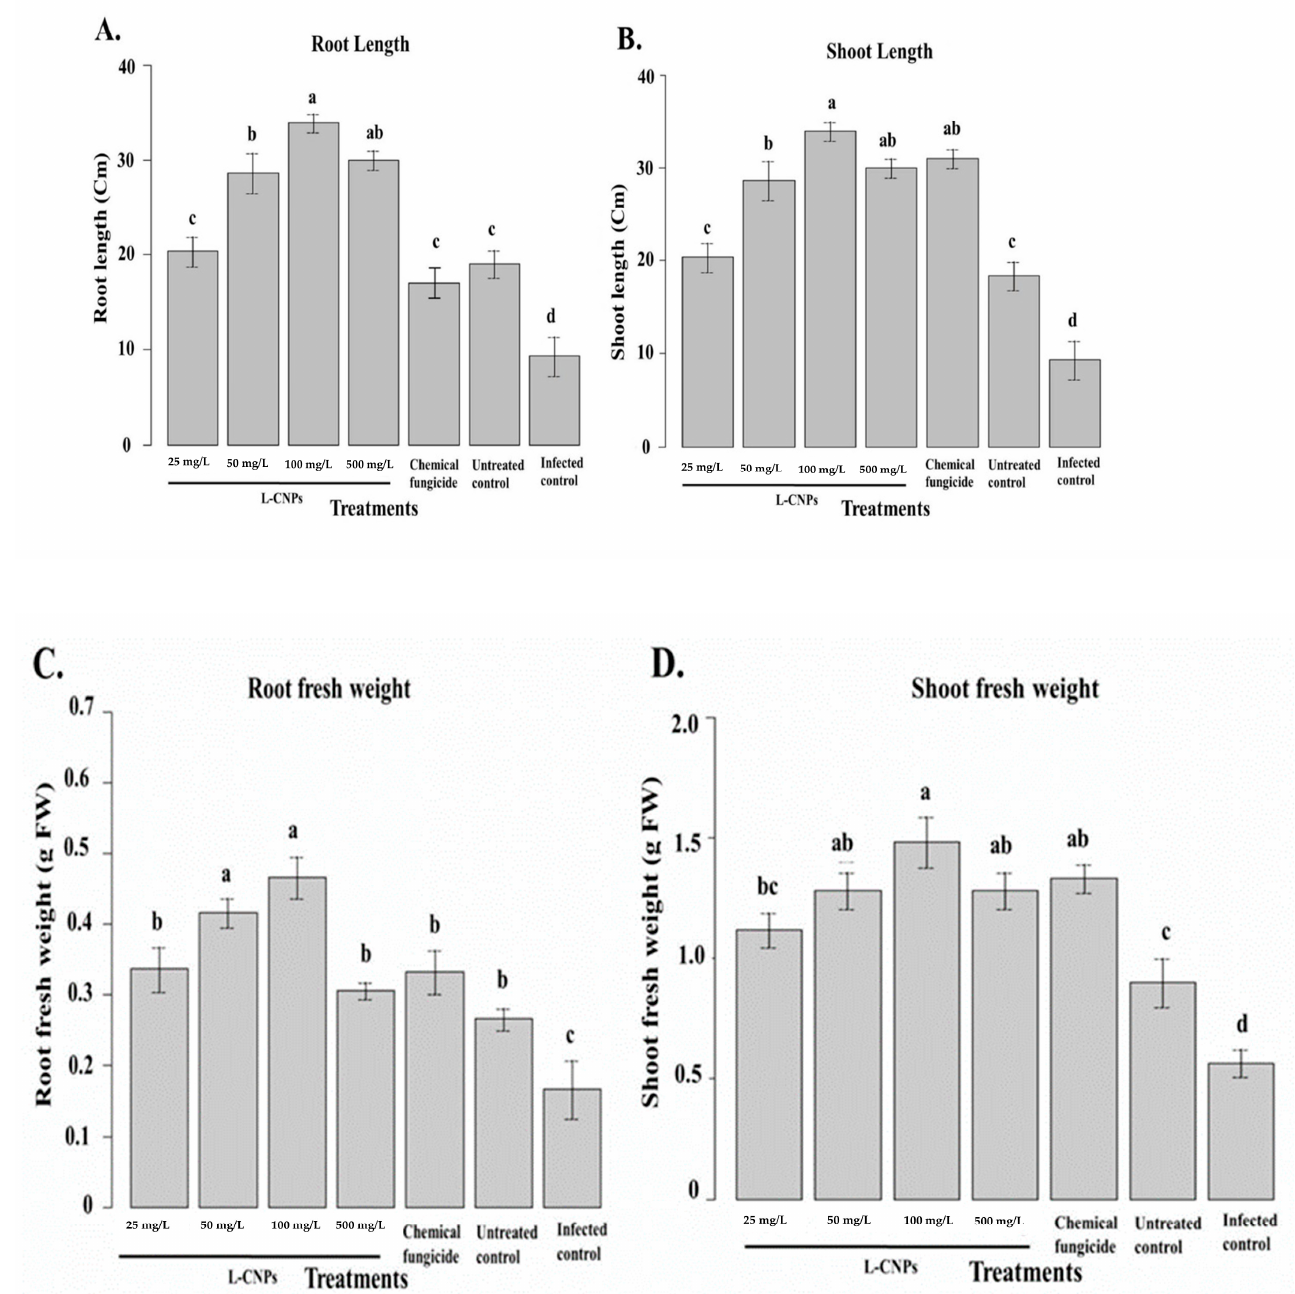
Figure 5. Effect of the treatment with L-CNPs on the length and fresh weight of maize samples com- pared to the chemical fungicide and the untreated controls. (L-CNPs25, L-CNPs50, L-CNPs100, and L-CNPs500) refer to L-CNPs concentration applied to seed for priming ( A ); effects of the treatments with L-CNPs on the shoot length; ( B ) shoot length; ( C ) root fresh weight; and ( D ) shoot fresh weight compared to the untreated control. The values were recorded on seedlings at 14 DAS. Letters in the figure, if different, indicate statistically significant differences of p < 0.05 between